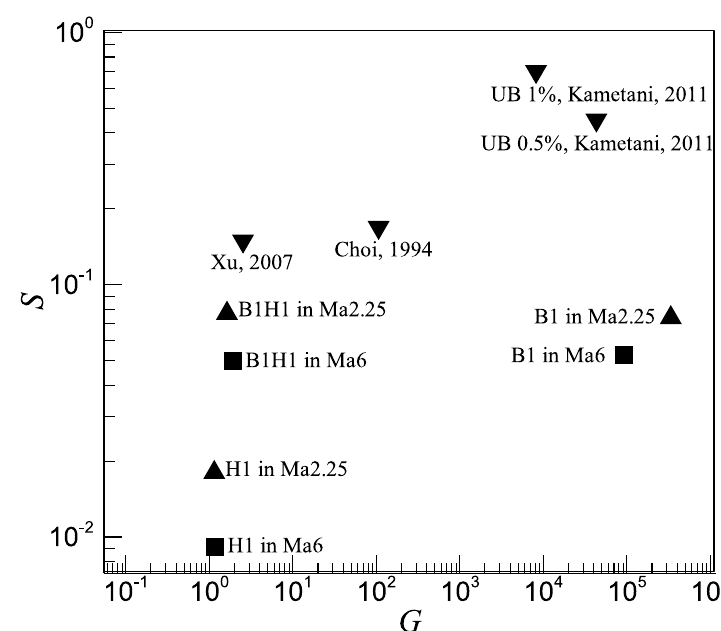
Fig. 7 Net energy saving rate S versus gain G and comparisons with other control